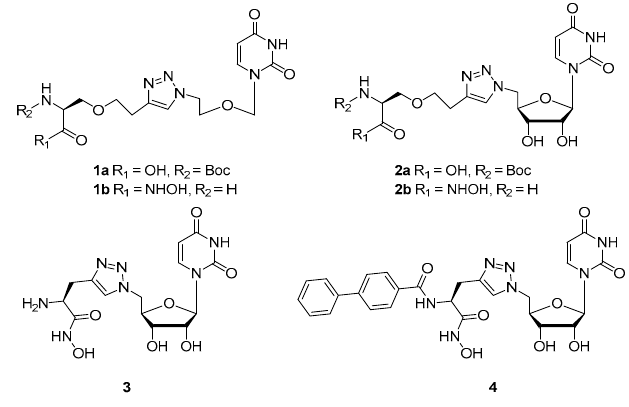
Figure 2. The structures of the nucleoside-amino acid conjugates.